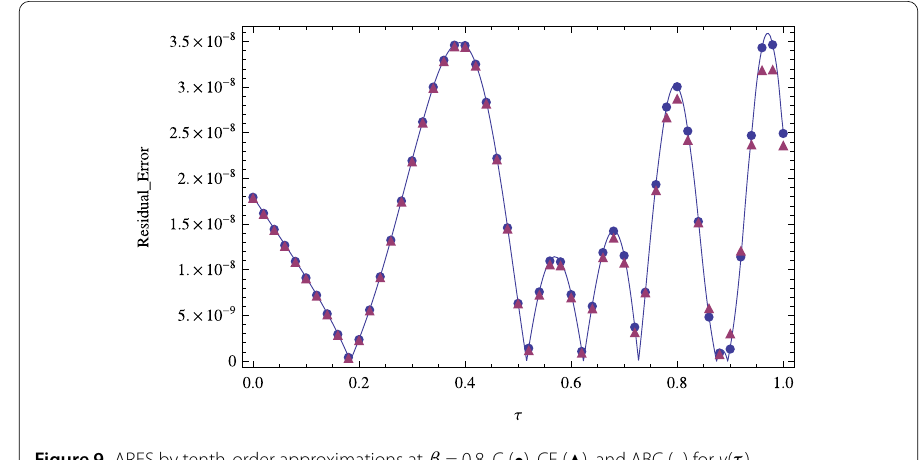
Figure 9 ARES by tenth-order approximations at β = 0.8, C ( • ), CF ( (cid:2) ), and ABC (–) for y ( τ )